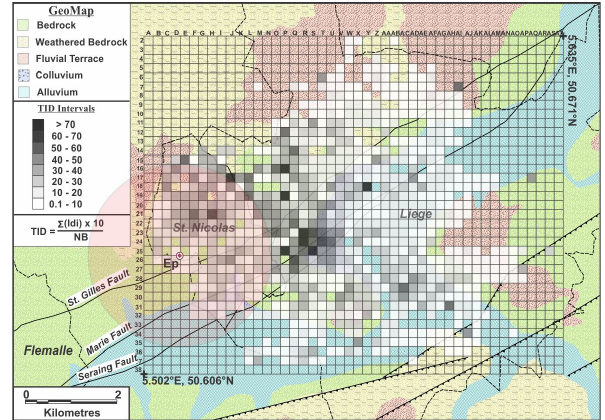
Fig. 2. Geographical distribution of the total damage index or TID over Li`ege and Saint Nicolas localities according to the PSE-UL report. Id i : damage index; NB: total number of buildings per square area; Ep: epicentre; red circle: epicentre uncertainty. Numbers and letters represent the coordinate system of the